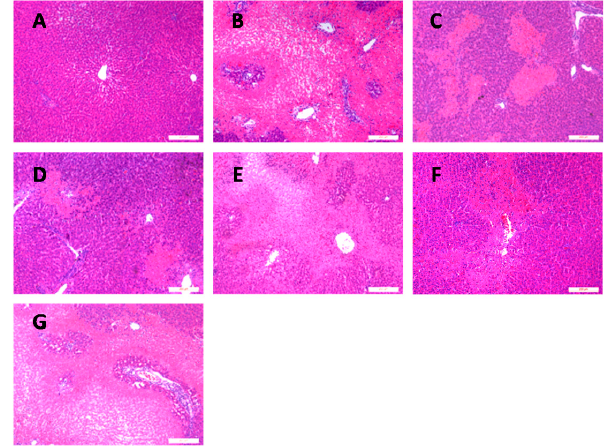
Figure 1. Histological changes in the liver of each group. Representative microphotographs taken from from group S ( A ), group M ( B ), group D1 ( C ), group D2 ( D ), group B1 ( E ), group B2 ( F ), and group group S ( A ); group M ( B ); group D1 ( C ); group D2 ( D ); group B1 ( E ); group B2 ( F ); and group B3 ( G ). B3 ( G ). (H and E stain, 100× magnification; scale bars, 200 μ m). (H and E stain, 100 ˆ magnification; scale bars, 200 µ